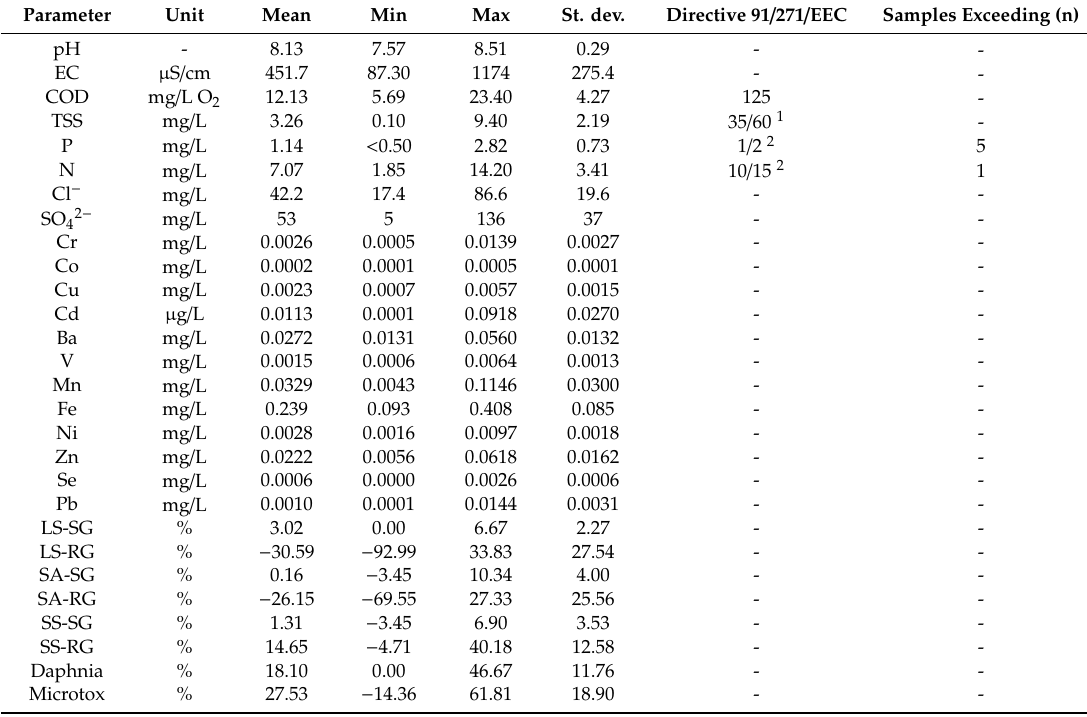
Table 1. Basic statistics of water quality parameters in wastewater treatment plant (WWTP) e ffl uents ( n = 21), concentration requirements for urban WWTP discharges according to Directive 91 / 271 / EEC and number of samples exceeding the